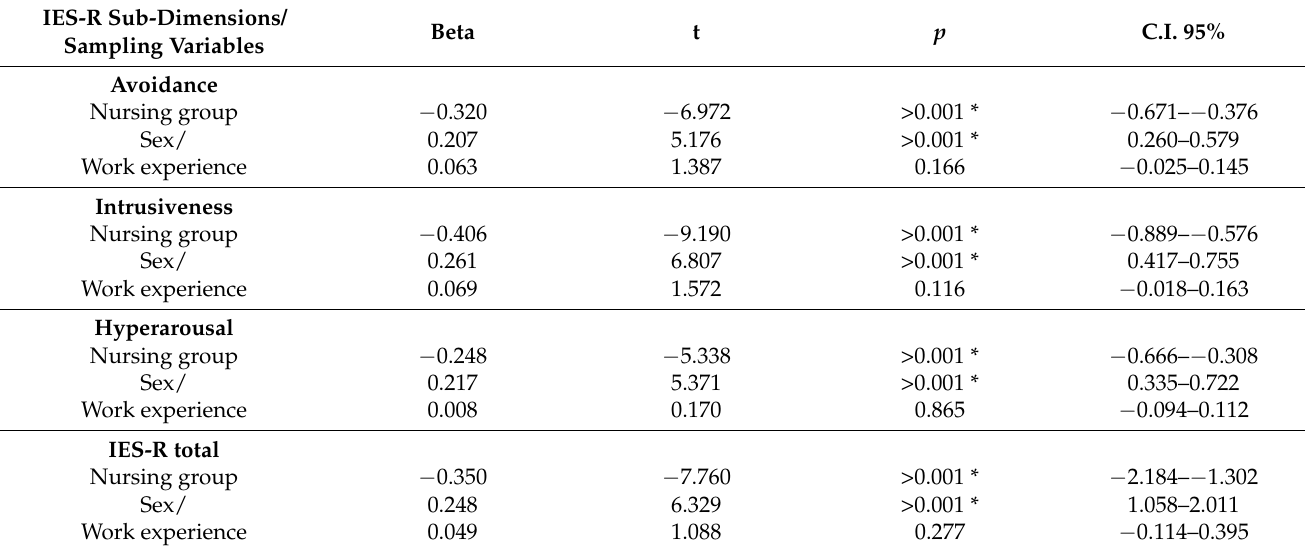
Table 4. IES-R values recorded in Nurses and Nursing Students according to Sex and Work